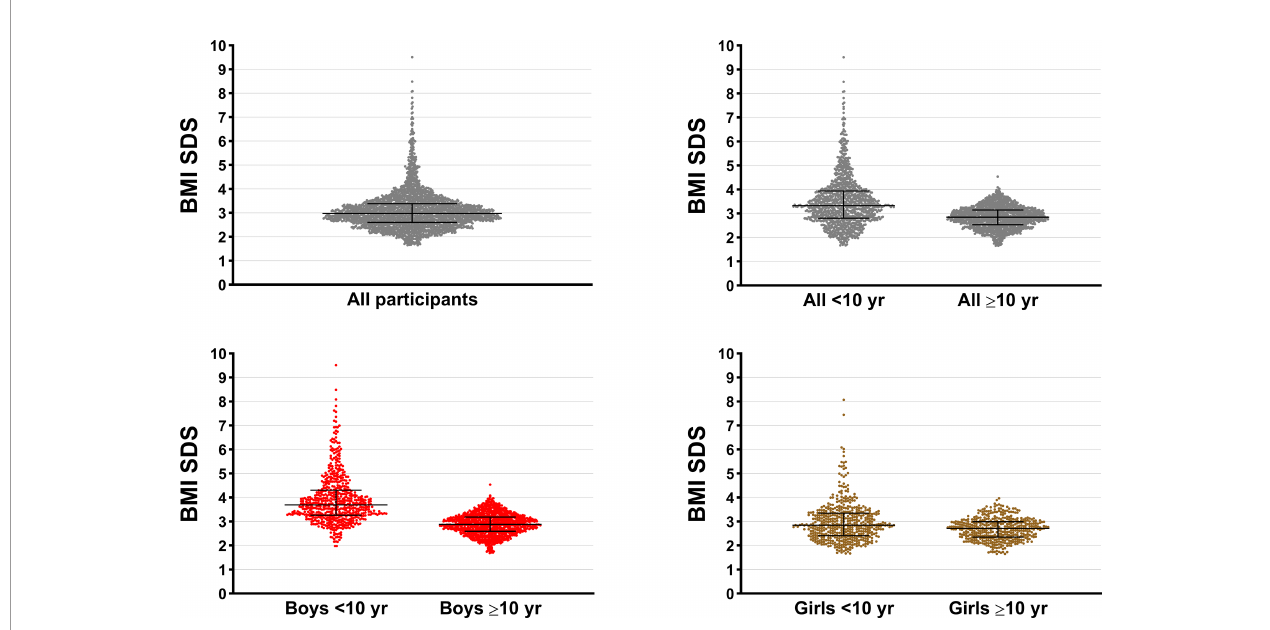
FIGURE 1 | Distribution of body mass index SD scores (BMI SDS) among our study population of children and adolescents with obesity assessed in 2008 – 2017 in Hangzhou (Zhejiang Providence, China). Horizontal bars represent the median and the interquartile